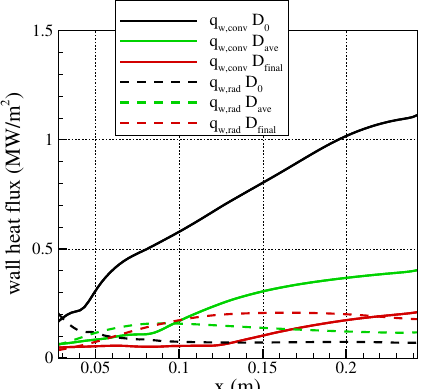
Figure 14. Effect of port diameter on wall heat flux for test 3 of set